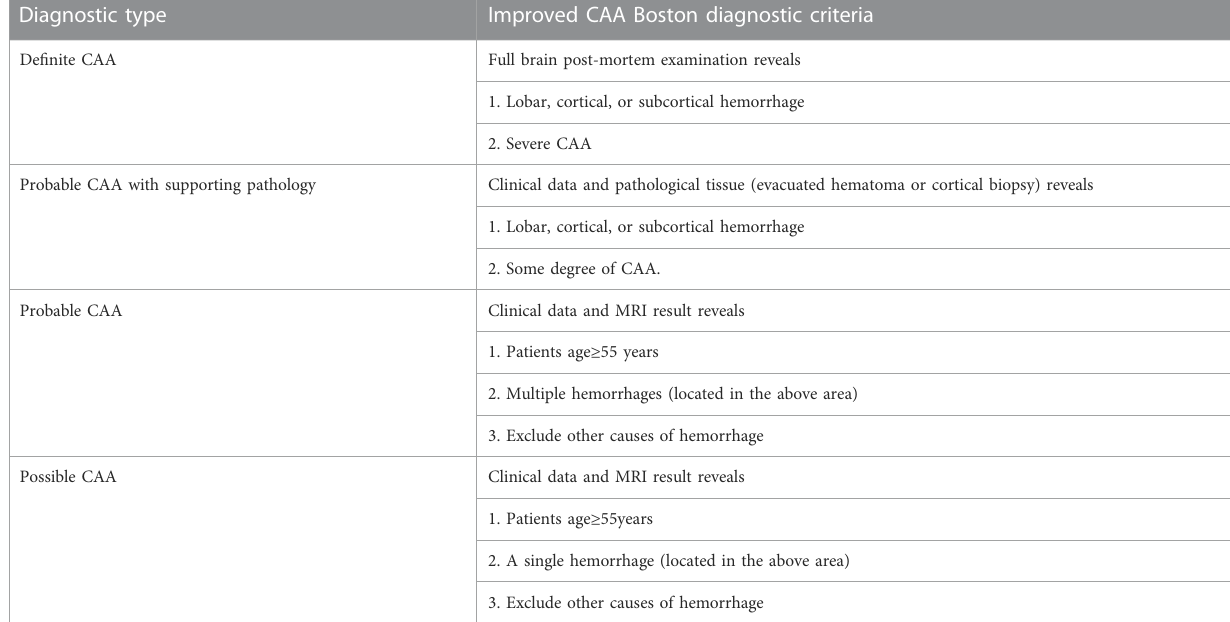
TABLE 2 Boston criteria version 1.0 for CAA (Greenberg and Vonsattel,